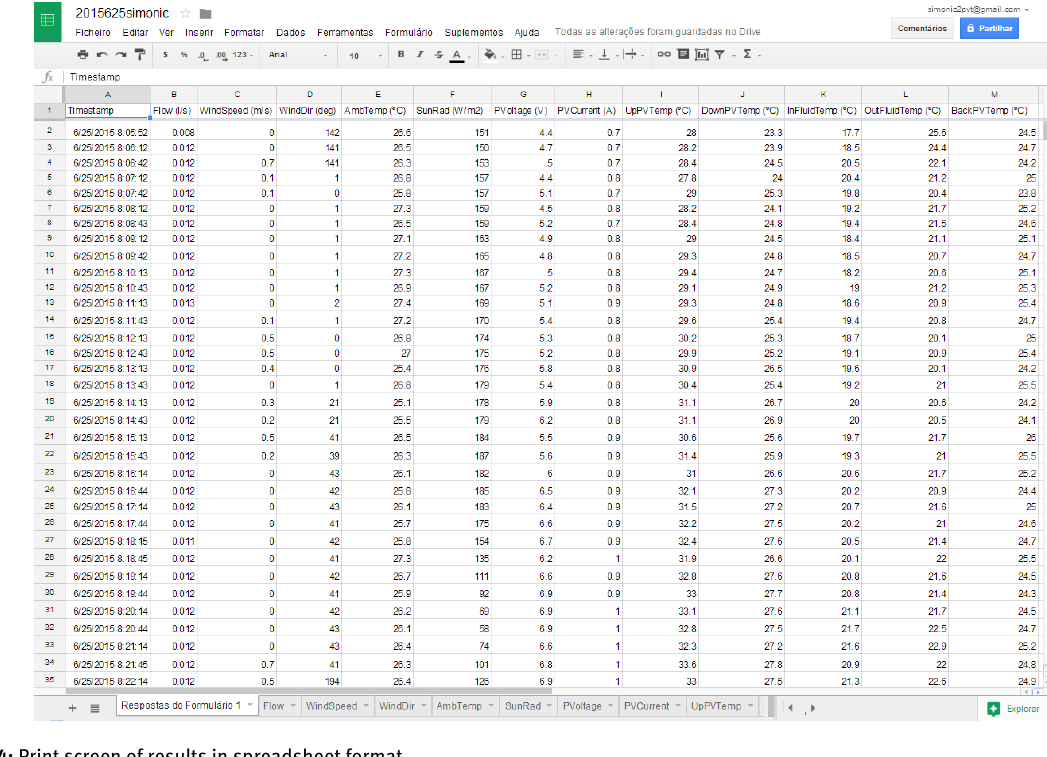
Figure 4: Print screen of results in spreadsheet format.